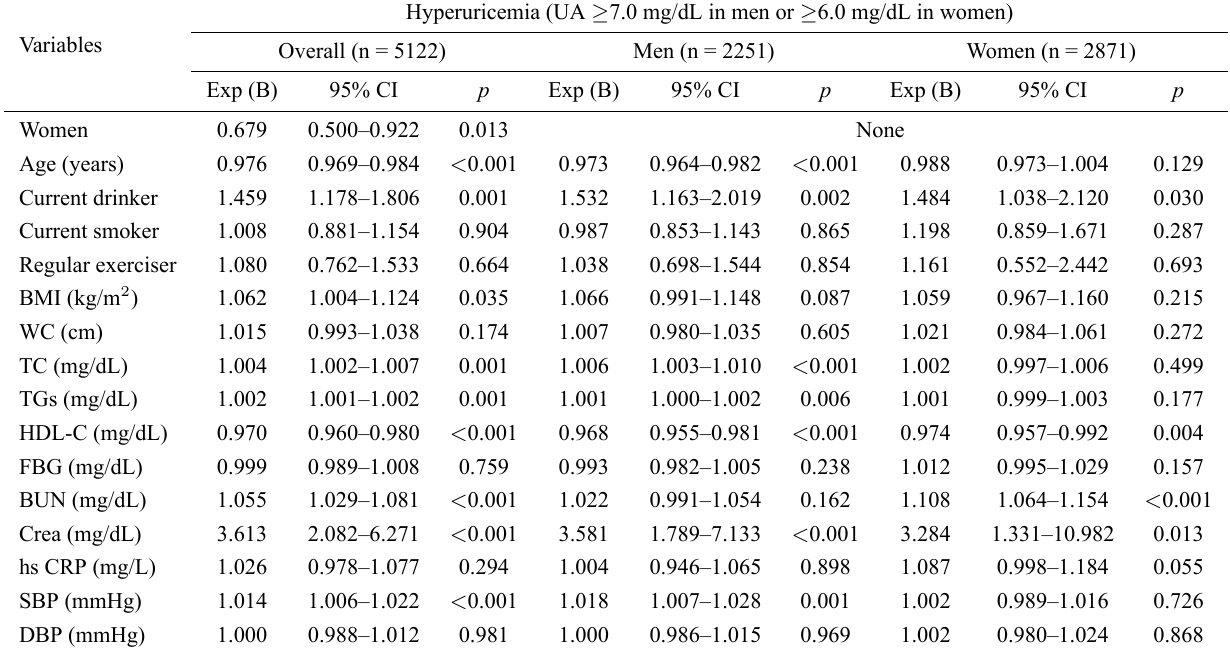
Table 3. Comparisons of hyperuricemia and systolic and diastolic blood